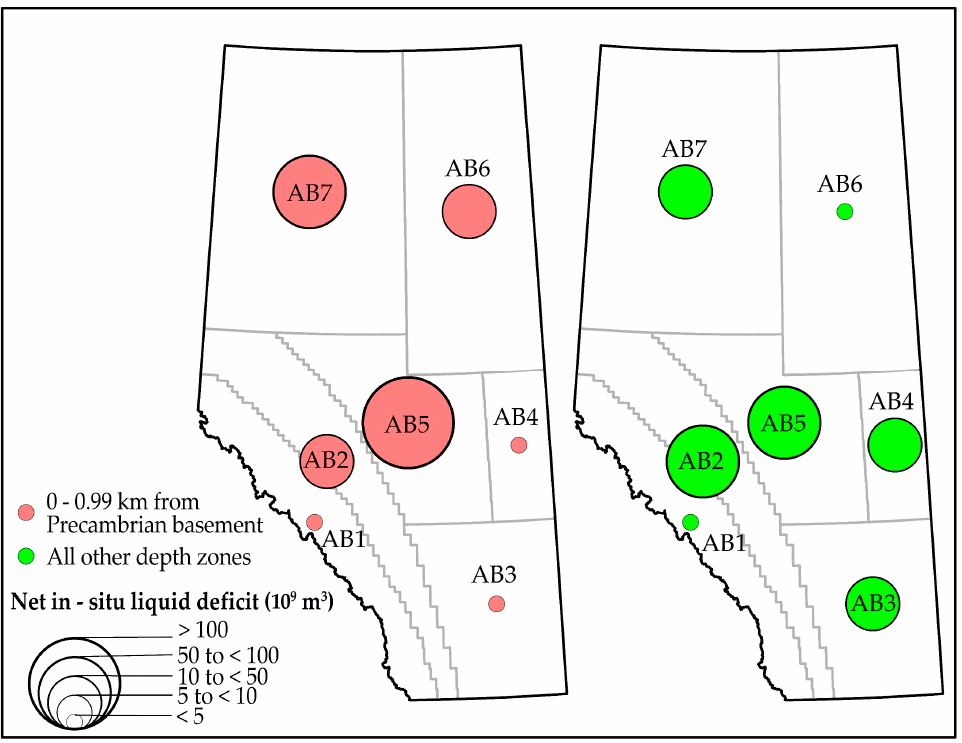
Figure 16. Calculated net in situ liquid deficit in the Alberta Basin (as of 31 December 2020). Source data extracted from geoLOGIC Systems databases © 2020.